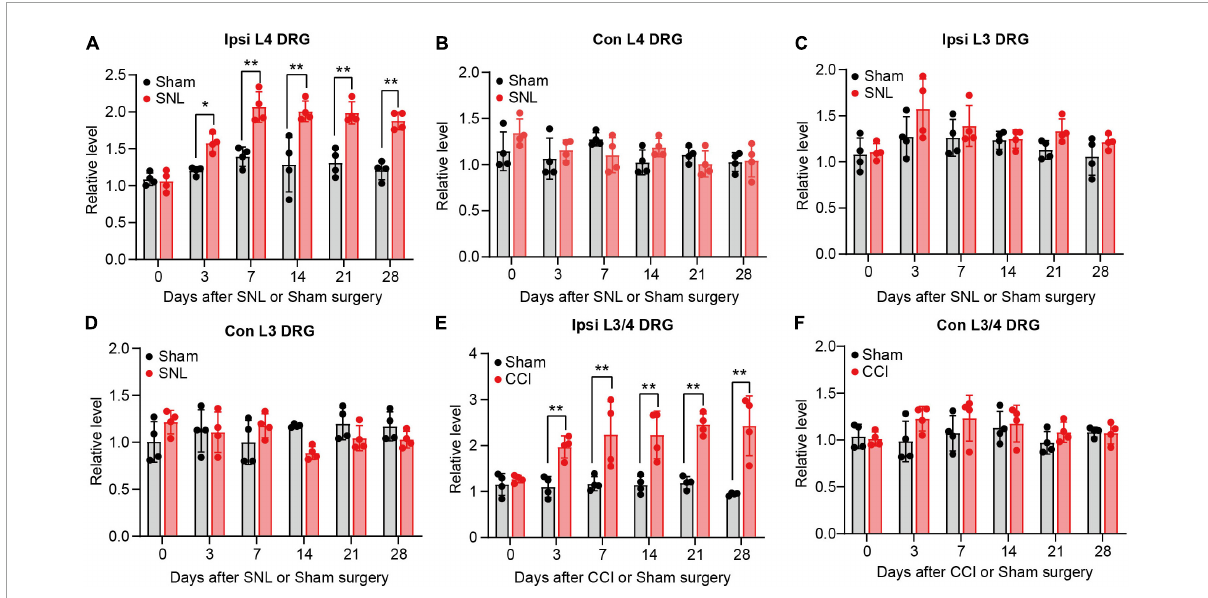
FIGURE2 Rhabdomyosarcoma 2-associated transcript ( Rmst ) upregulation was found in damaged DRG of mice after SNL or CCI model. (A–D) Level of Rmst in ipsilateral L4 DRGs (A) , contralateral L4 DRGs (B) , ipsilateral L3 DRGs (C) , and contralateral L3 DRGs (D) after SNL or sham surgery n = 16. (E,F) Levels of Rmst in the ipsilateral (E) and contralateral (F) side L3/4 DRGs after CCI or sham surgery n = 8. Two-way ANOVA followed by post-hoc Tuckey test. * P < 0.05 and ** P < 0.01 compared with sham group at each time point.